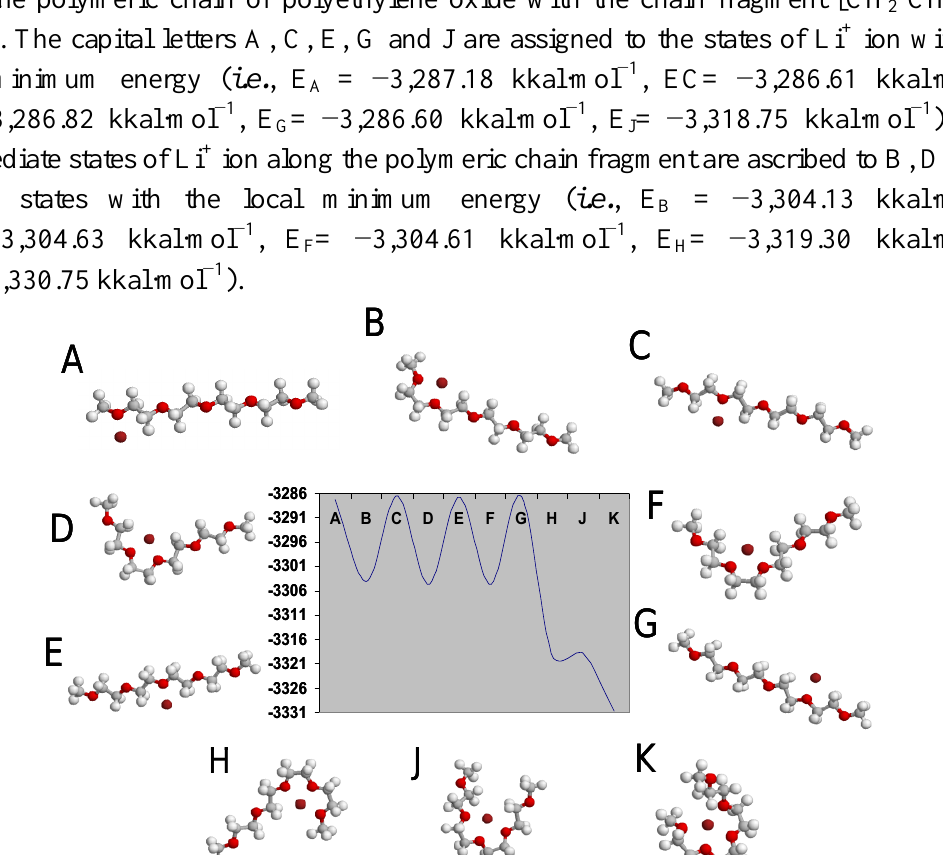
= −3,287.18 kkal·mol −1 , EC= −3,286.61 kkal·mol −1 , A = −3,286.60 kkal·mol −1 , E G = −3,304.61 kkal·mol −1 , E F